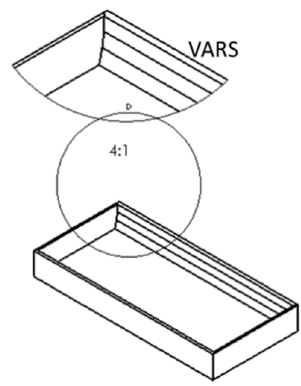
Figure 8. Varied angles of the reflection surface (VARS) implemented on the end wall.